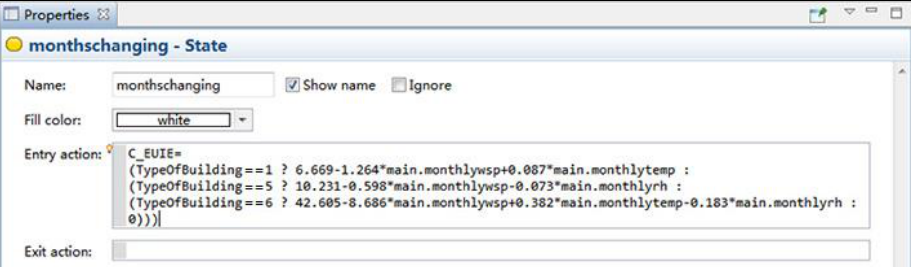
Figure 7. Calculation command under the urban morphology sub-model of the building agent.